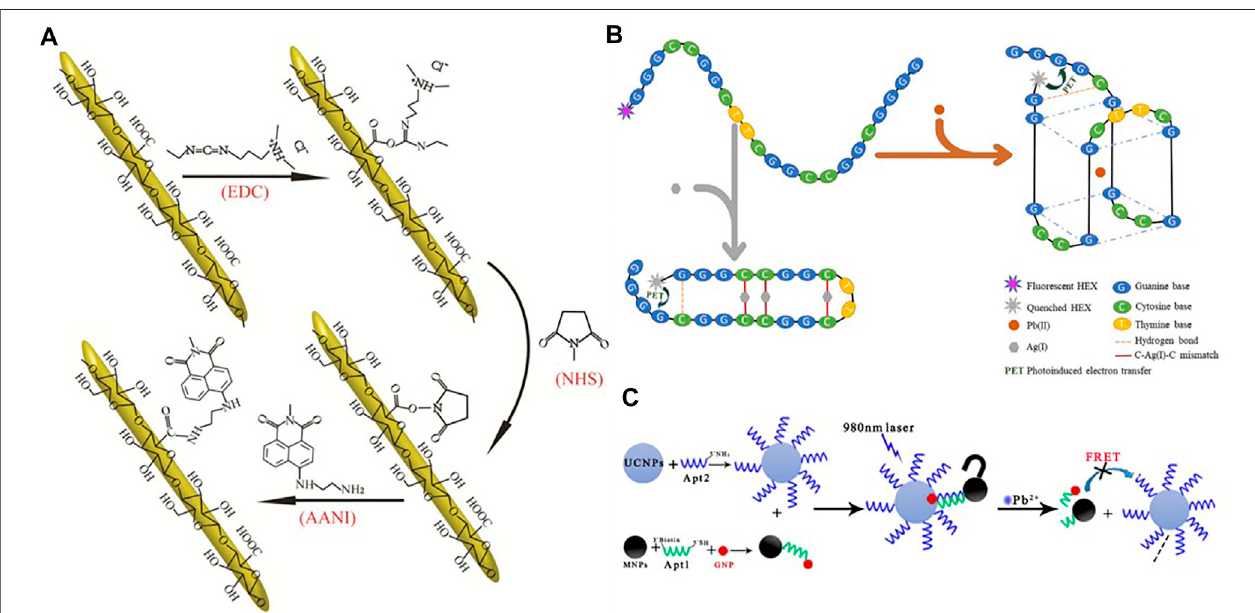
FIGURE 8 | (A) Schematic synthesis route of the covalent immobilization of 1,8-naphthalimide dye on the surface of CNC (Song et al., 2019); (B) Schematic diagram for illustrating the simultaneous detection of Pb (II) and Ag (I) ions utilizing single-labelled fl orescent OND probe (Zhang J. et al., 2021); (C) a Schematic presentation of fl uorescent nanoprobe based on fl uorescence resonance energy transfer (FRET) between UCNPs and GNPs-MNPs for detection of Pb 2+ (Chen et al., 2020).